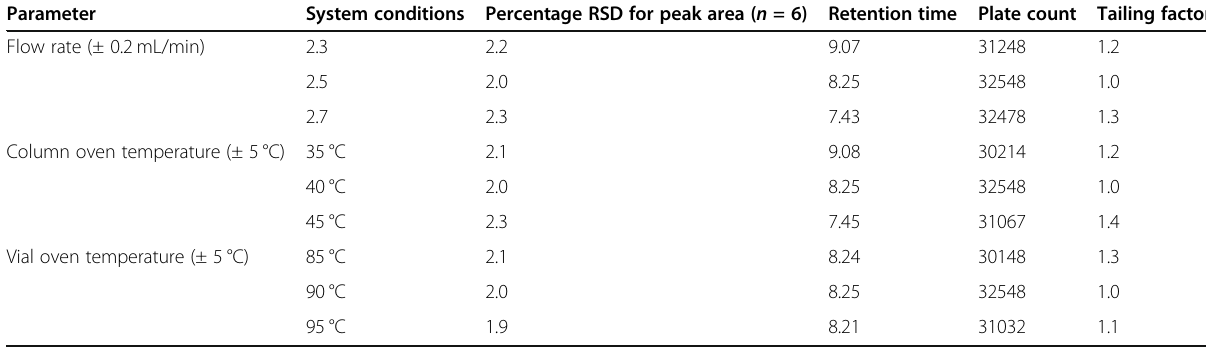
Table 22 Robustness study results of isopropyl alcohol